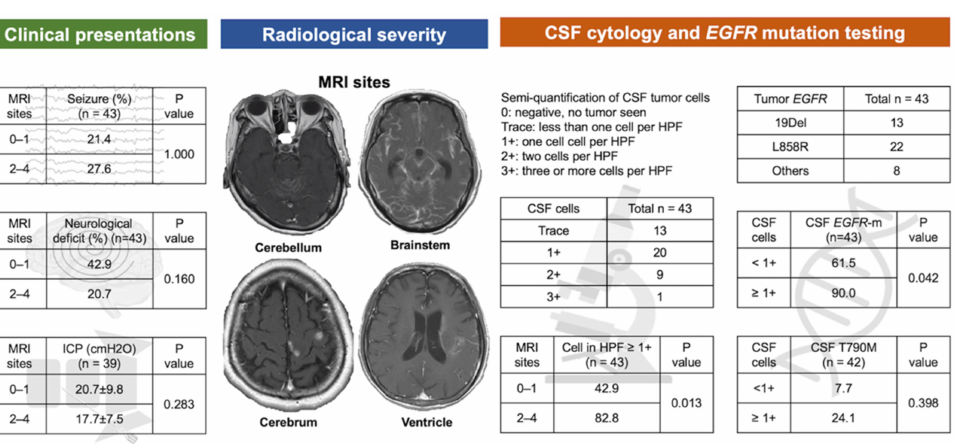
Figure 2. Clinical presentation, extent of leptomeningeal metastasis on brain MRI, and the yield rate of EGFR mutation in cerebrospinal fluids